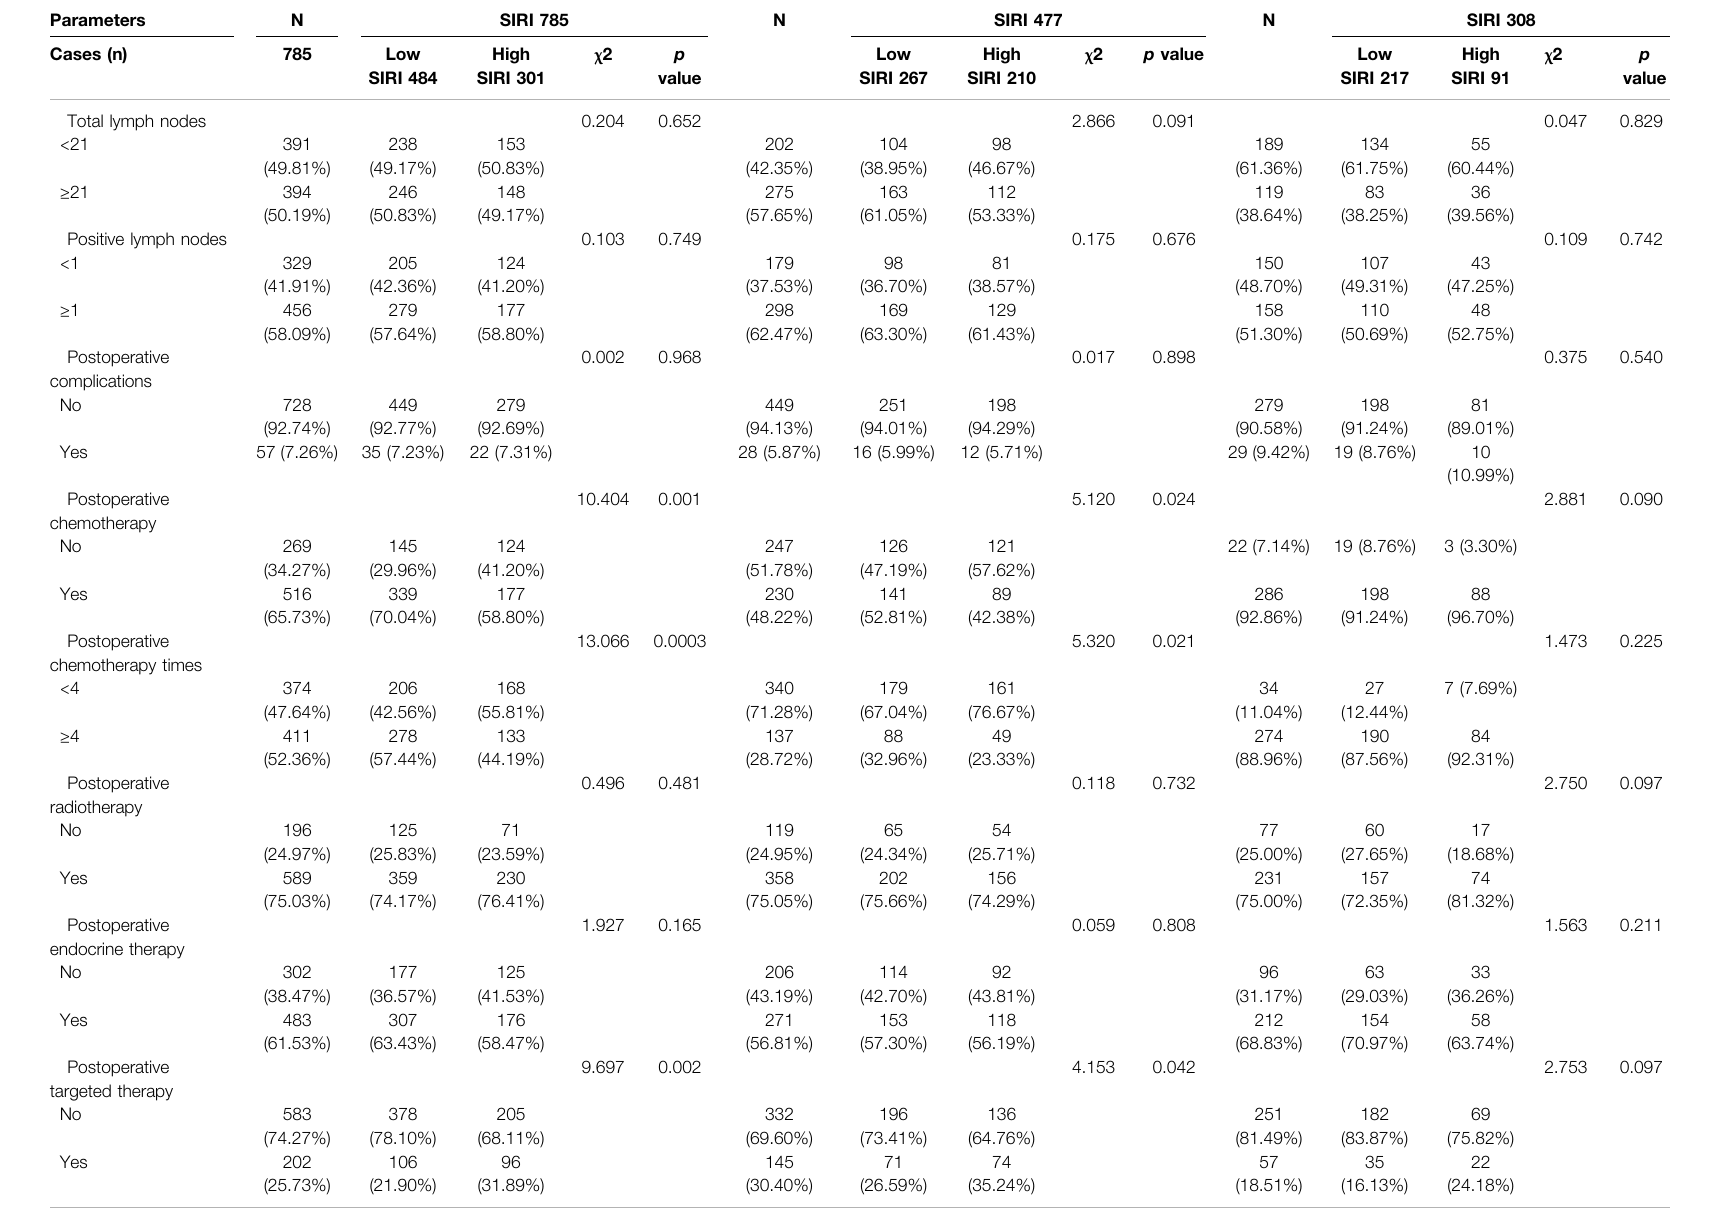
TABLE 1 | ( Continued ) Demographic and clinicopathologic characteristics of 785 patients with breast